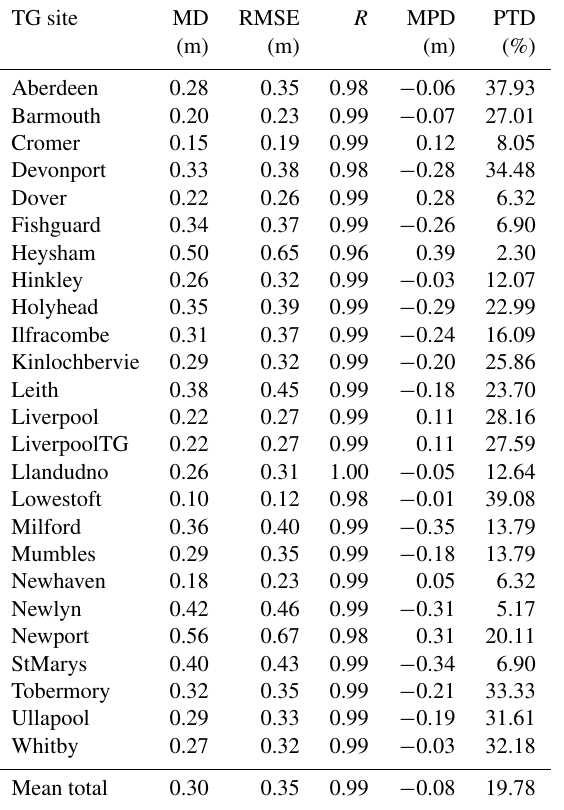
Table A2. Comparison of tide to TGs from 1 December 2013 to 28 February 2014. To assess against observations with a higher tem- poral frequency than model outputs, both the TG and the model data are interpolated to 1min time series and then re-averaged within the hour. In some cases, we found an offset of 1h in the peak time from model and observation. The percentage of peaks misrepresented by the model is shown in the last column. In nearly all these cases the model peaks occur 1h earlier than in observations. The columns show the TG site names, the mean absolute difference between the model minus the TG (MD), the root-mean-square error (RMSE), the correlation ( R ), the mean peak magnitude difference (MPD), and the number of cases in which the model peaks were offset in time compared to that of TGs, i.e. the peak time difference